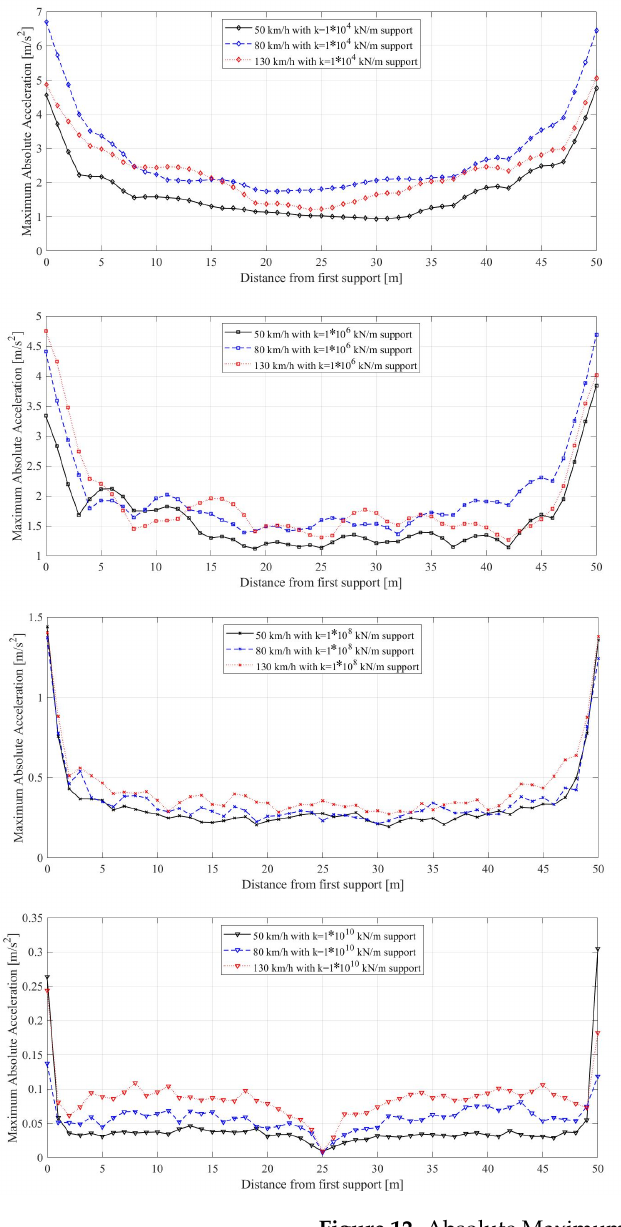
Figure 12. Absolute Maximum Accelerations along the bridge length for different bearing stiffness and train speeds for the two span